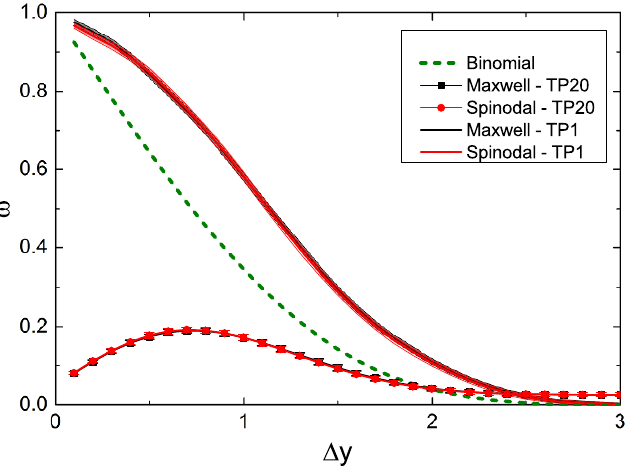
Figure 10 . The scaled variance of the net baryon number as a function of the rapidity window size around mid-rapidity. Di(cid:11)erent scenarios are shown: the results for TP=1 and TP=20 with spinodal and Maxwell EoS, as well as a binomial